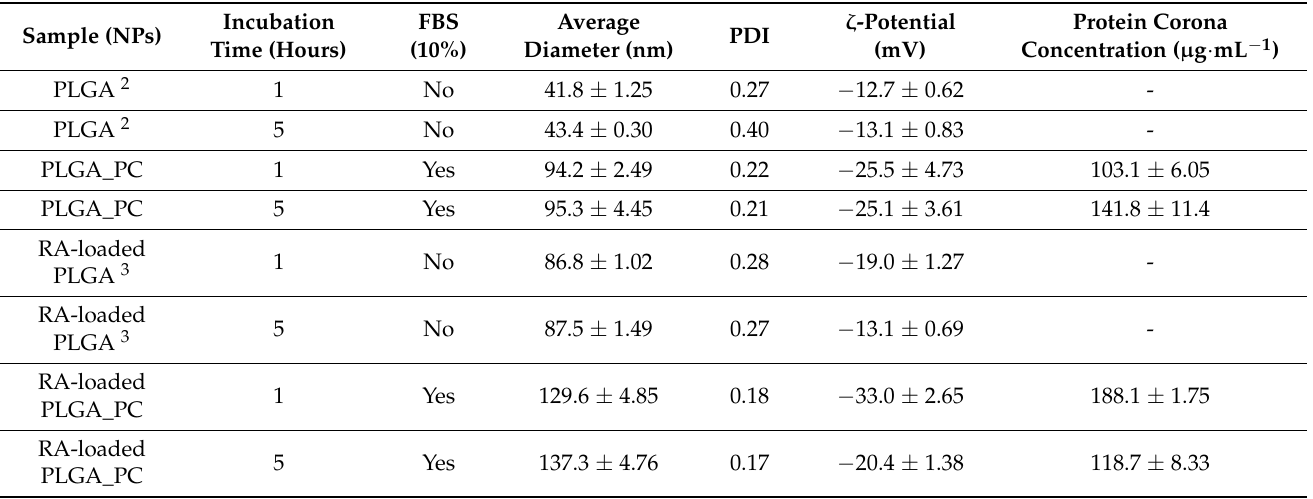
Table 2. Biophysical characterization of the pre-formed protein corona (PC) adsorbed on the surface of PLGA polymeric NPs 1